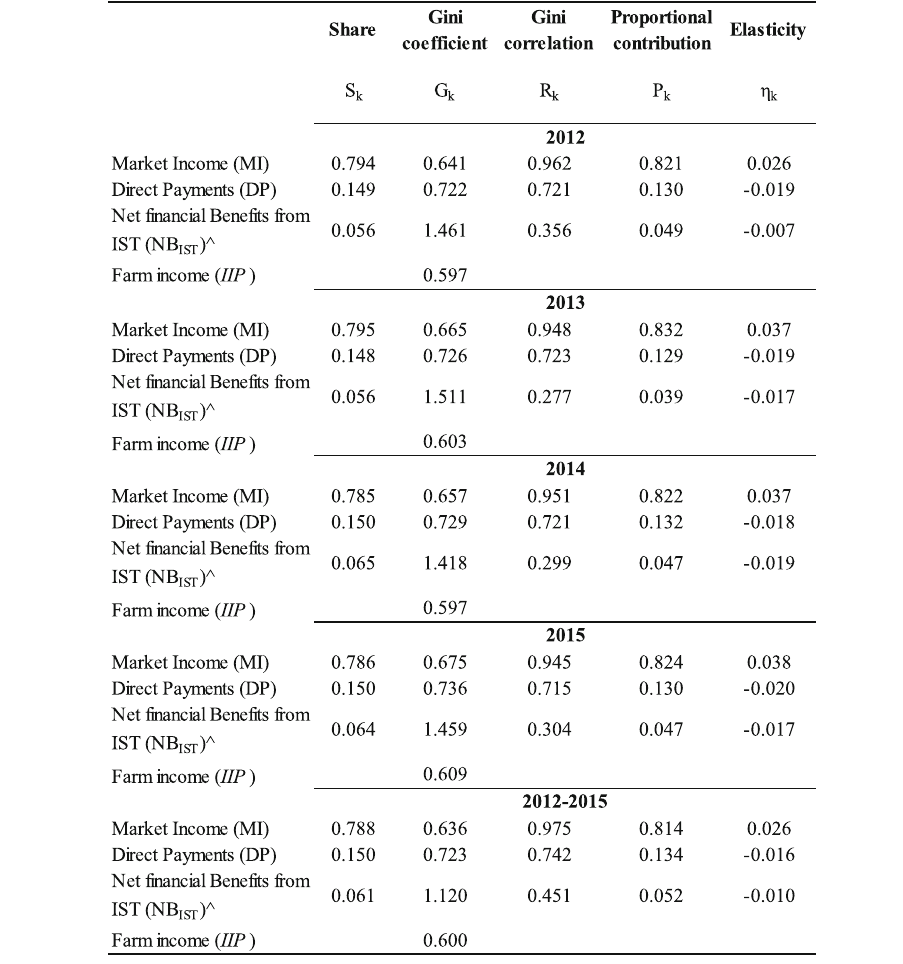
Table 4 Gini decomposition by income sources. All farm sample, years from 2012 to 2015 and whole